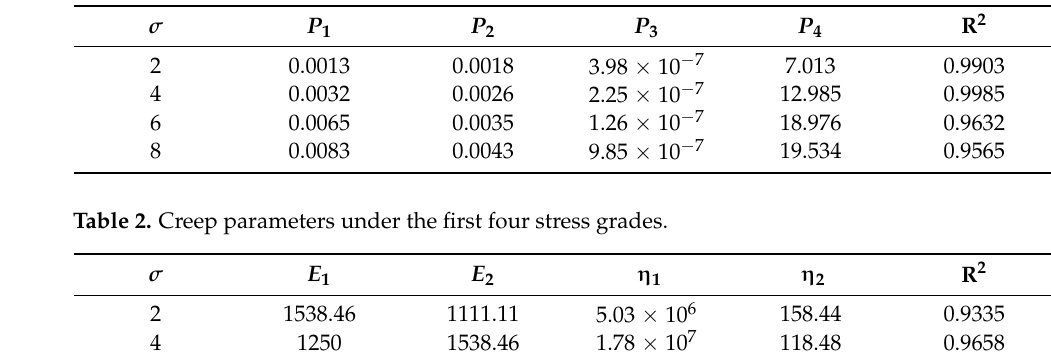
Table 1. Fitting parameters under the first four stress levels.